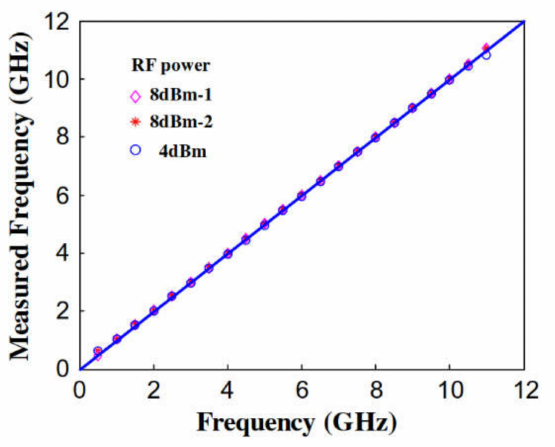
Figure 4. Estimated frequency based on measured power ratio function (Adapted with permission from Ref [25]. Copyright 2010,